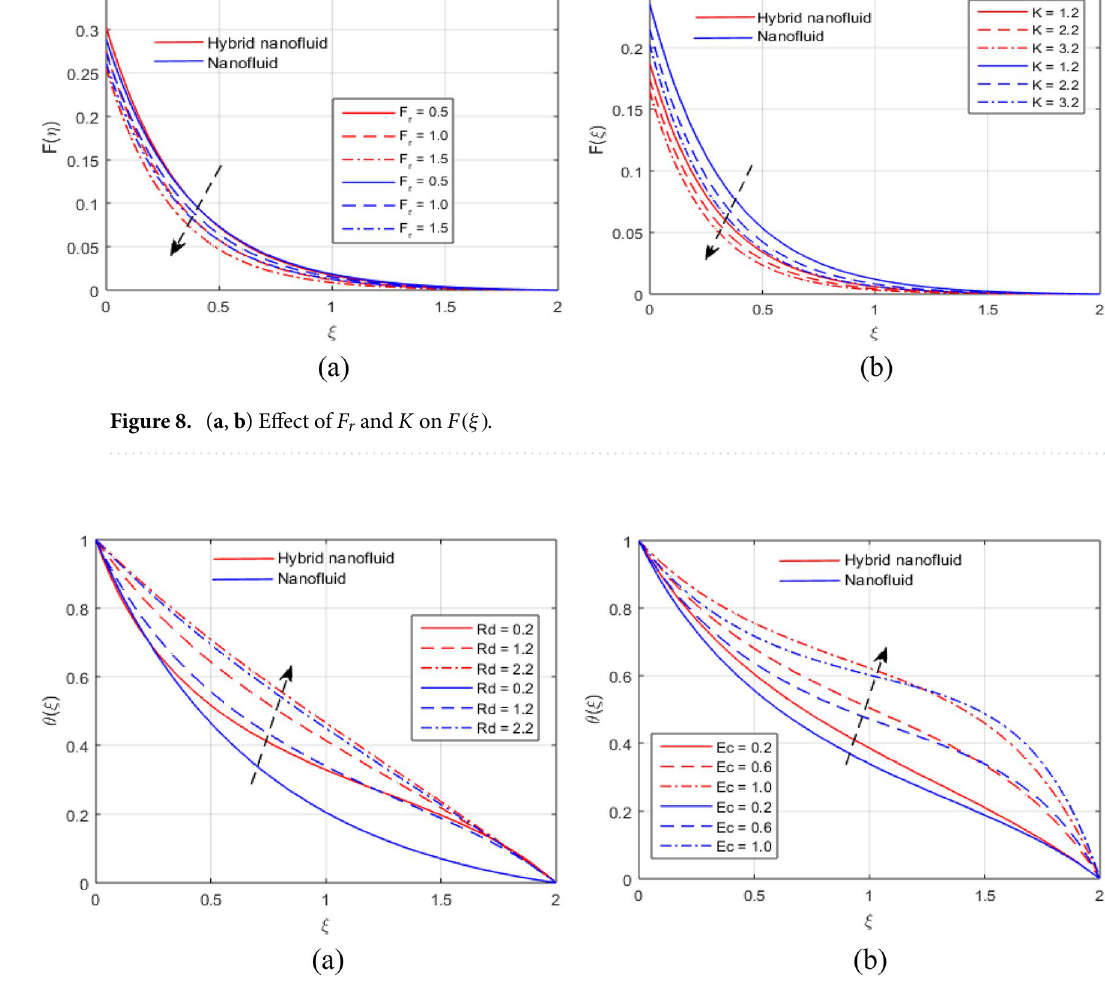
Figure 9. ( a , b ) Influence of Rd and Ec on θ(ξ) .